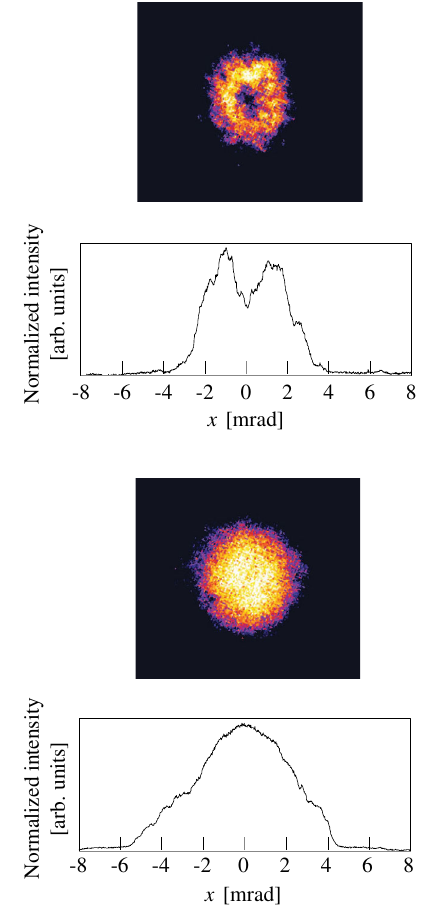
FIG. 6. Demonstration of redshifting in the ICS fundamental frequency using a Fe K -edge filter. Single-shot x-ray-intensity distributions were observed on the MCP screen with an upstream 50 μ m Fe foil (7.2 keV K -edge) in 10 mrad square: (upper) a < 0 . 25 case when the fundamental high-energy edge is near L 7.6 keV; and (lower) 0 . 5 < a L < 0 . 7 case when this edge drops into the K -edge transmission window. The contrast is adjusted for these color-rendered MCP images. Lineout profiles corre- spond to the line y ¼ 0 , giving the intensity distributions measured by the